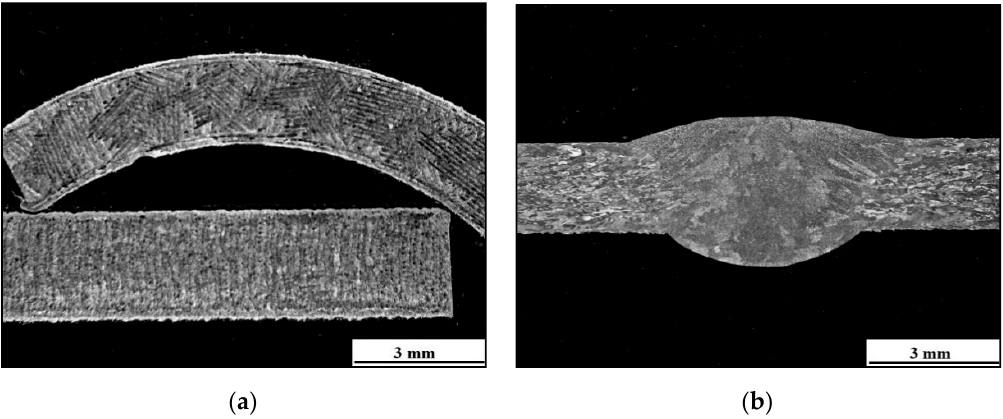
Figure 8. ( a ) Transverse section (on the top) and longitudinal section (on the bottom) of the base material; ( b ) macrostructure of the welded joint.